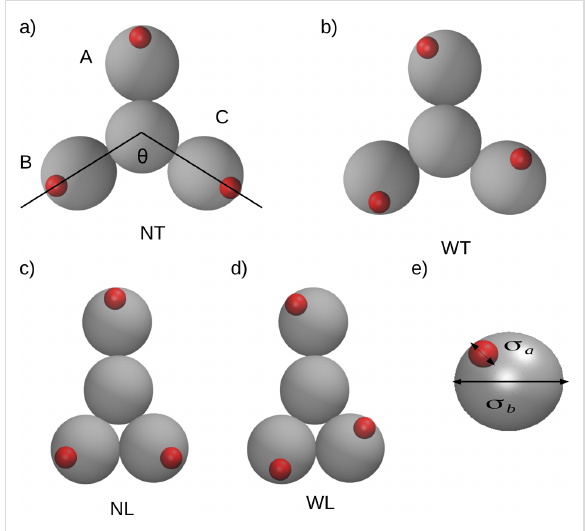
Figure 1: a–d) Schematic representation of the models used in this work. Silver and red circles correspond to the components of the back- bone and “phantom” active sites, respectively. In a) we can see that the arms are marked as A, B, and C. e) Parameters of the molecular dynamics